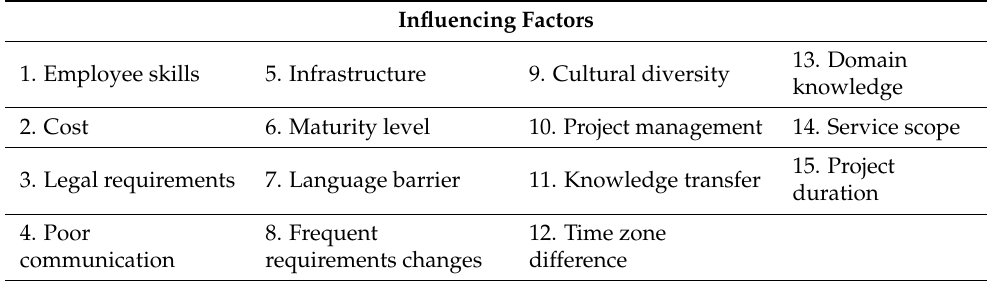
Figure 1. Proposed method of the OffshoringDSS. Table 1. List of influencing factors.